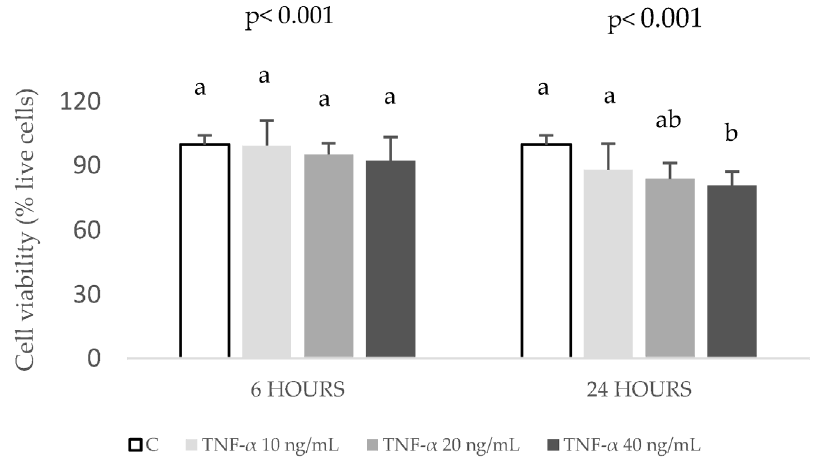
Figure 2. Effects of TNF- α at 0 (control, C), 10, 20 and 40 ng/mL, during 6 and 24 h, on cell viability in HepG2 cultures. Results, expressed as % of live cells, are means ± SD (n = 3–6). The p values above the figures represent ANOVA results and the different letters denote statistical differences within the same time according to the Bonferroni test ( p < 0.05).